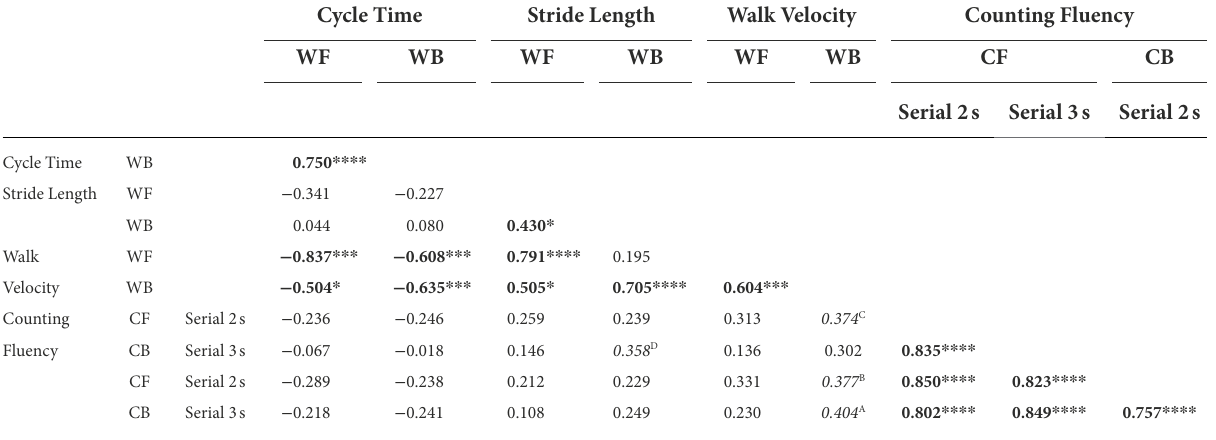
TABLE 1 Inter-correlation matrix between motor performance (cycle time, stride length, walking velocity) and cognitive performance (counting fluency) variables in the single-task conditions.